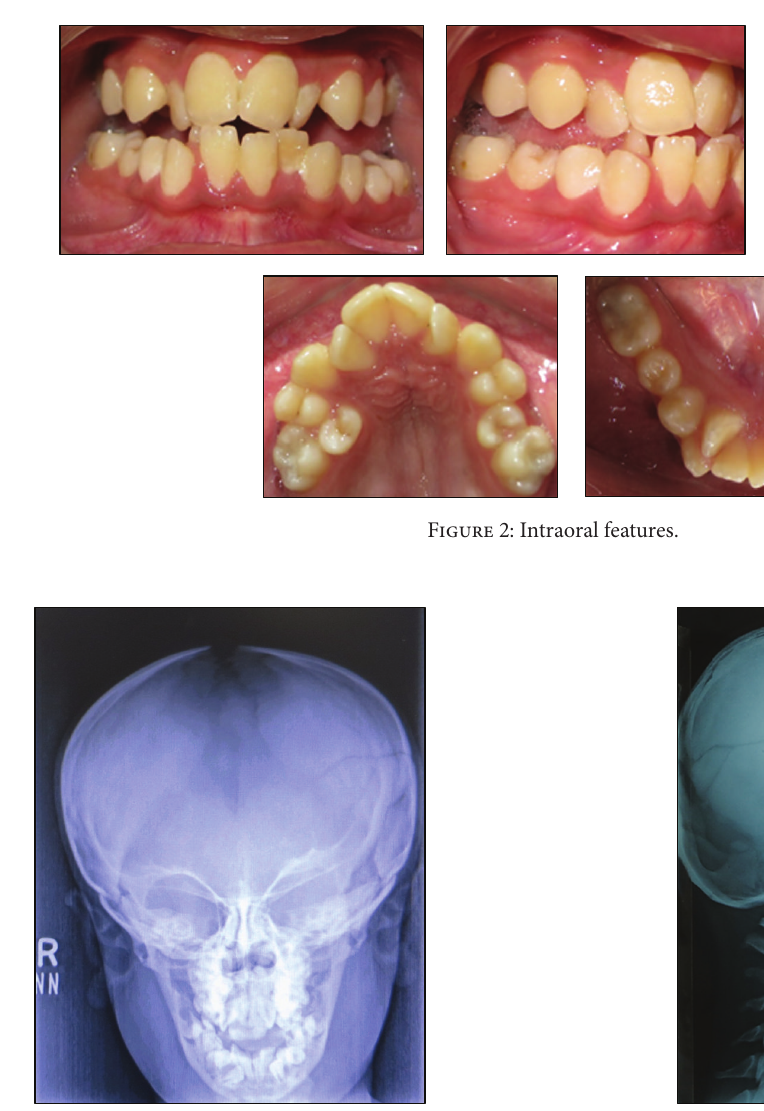
Figure 5: Cephalometric measurements and